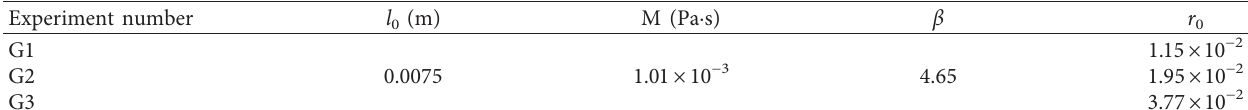
Table 3: Some basic penetration grouting parameters about the grouting verification experiments.